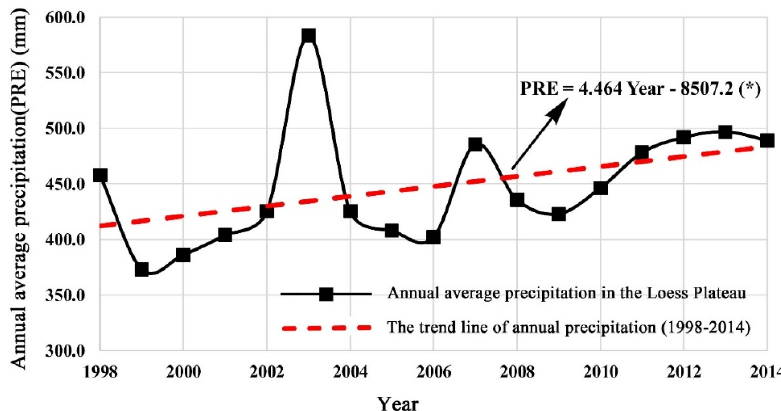
Figure 4. The changing trend of annual average precipitation in the period of 1998–2014. “*” means that the changing trend has passed the statistical significance test with 90% confidence level.